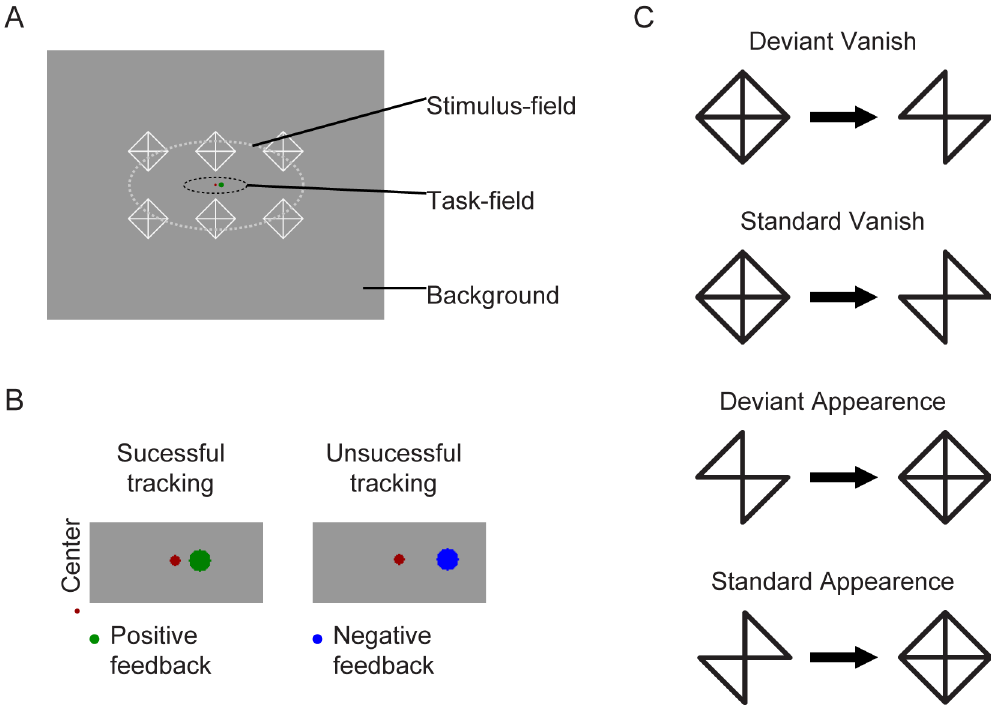
Fig 1. A. The stimulus display(ERP-related patterns and the task-field). B: The task field in case of successful and unsuccessful tracking. C. Sequence of stimuli; frequentlyvanishingelements(StandardVanish),appearanceof the pattern after the frequently vanishedelements(StandardAppearance), infrequentlyvanishedelements(Deviant Vanish), appearanceof the pattern after the infrequently vanishedelements(Deviant Appearance).